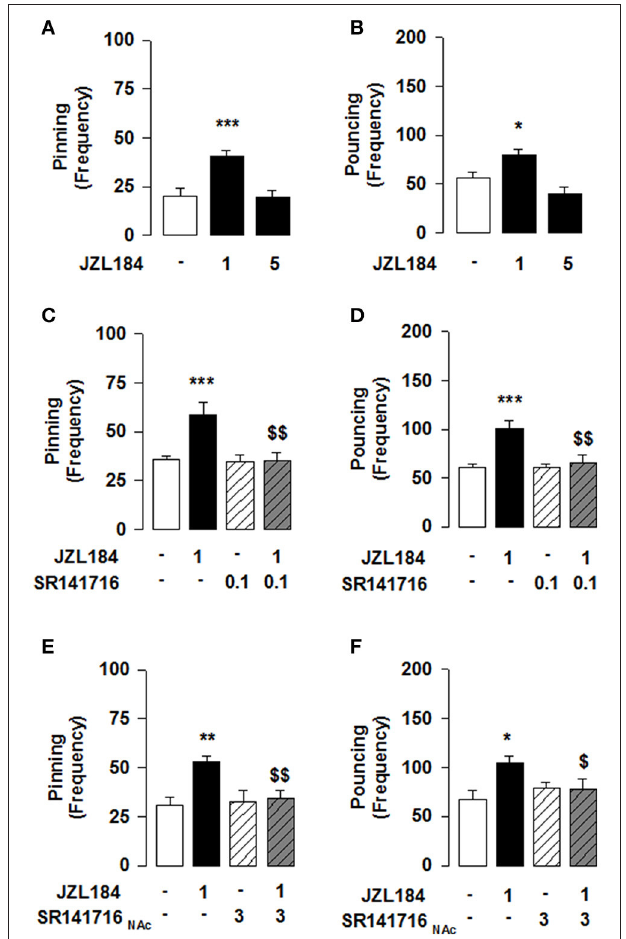
FIGURE 1 | 2-AG elevation stimulates social play via CB1R in the NAcC in adolescent rats. JZL184 (1 mg/kg, i.p.) enhanced pinning (A) and pouncing (B) frequency. Systemic pretreatment with the CB1R antagonist SR141716 (0.1 mg/kg, i.p.) blocked the effects of JZL184 on pinning (C) and pouncing (D) . Intra-NAcC infusion of SR141716 (3 µ g/0.3 µ l) antagonized the play-enhancing effects of JZL184 (1 mg/kg, i.p.) (E,F) . Data represent mean ± S.E.M. frequency of pinning and pouncing. * p < 0.05, ** p < 0.01, *** p < 0.001 vs. vehicle; $ p < 0.05, $$ p < 0.01 vs. vehicle/JZL184 (Student-Newman-Keuls post-hoc test). N = 7–9 per treatment